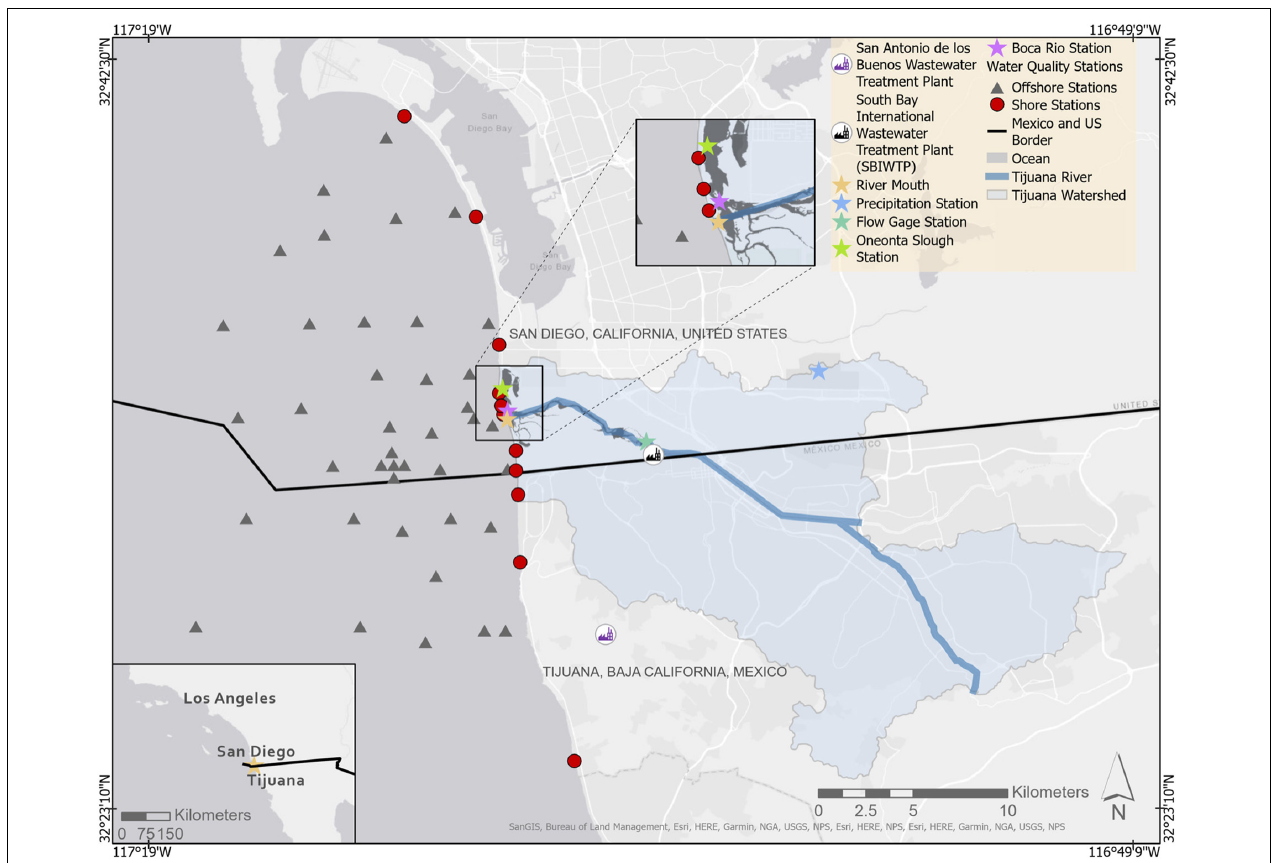
FIGURE 1 | The Tijuana River Watershed. The water quality sampling stations from The City of San Diego Public Utilities are denoted by red points and gray triangles. Automatic water quality sampling stations from the NOAA National Estuarine Research Reserve System (NERRS) located in the estuary are symbolized as a purple (Boca Rio Station) and light green star (Oneonta Slough Station). The Tijuana River mouth is symbolized as a yellow star and the flow gauge station is a green star near the United States Mexico border. The precipitation station is the blue star located at the Brown Field Municipal Airport. The South Bay International Wastewater Treatment Plant (SBIWTP) is located in San Diego, CA near the United States Mexico border. The San Antonio de los Buenos Wastewater Treatment Plant is located in Tijuana, Mexico situated south of the